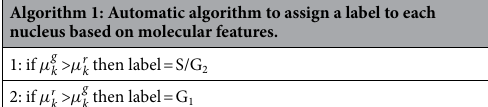
Algorithm 1: Automatic algorithm to assign a label to each nucleus based on molecular features.